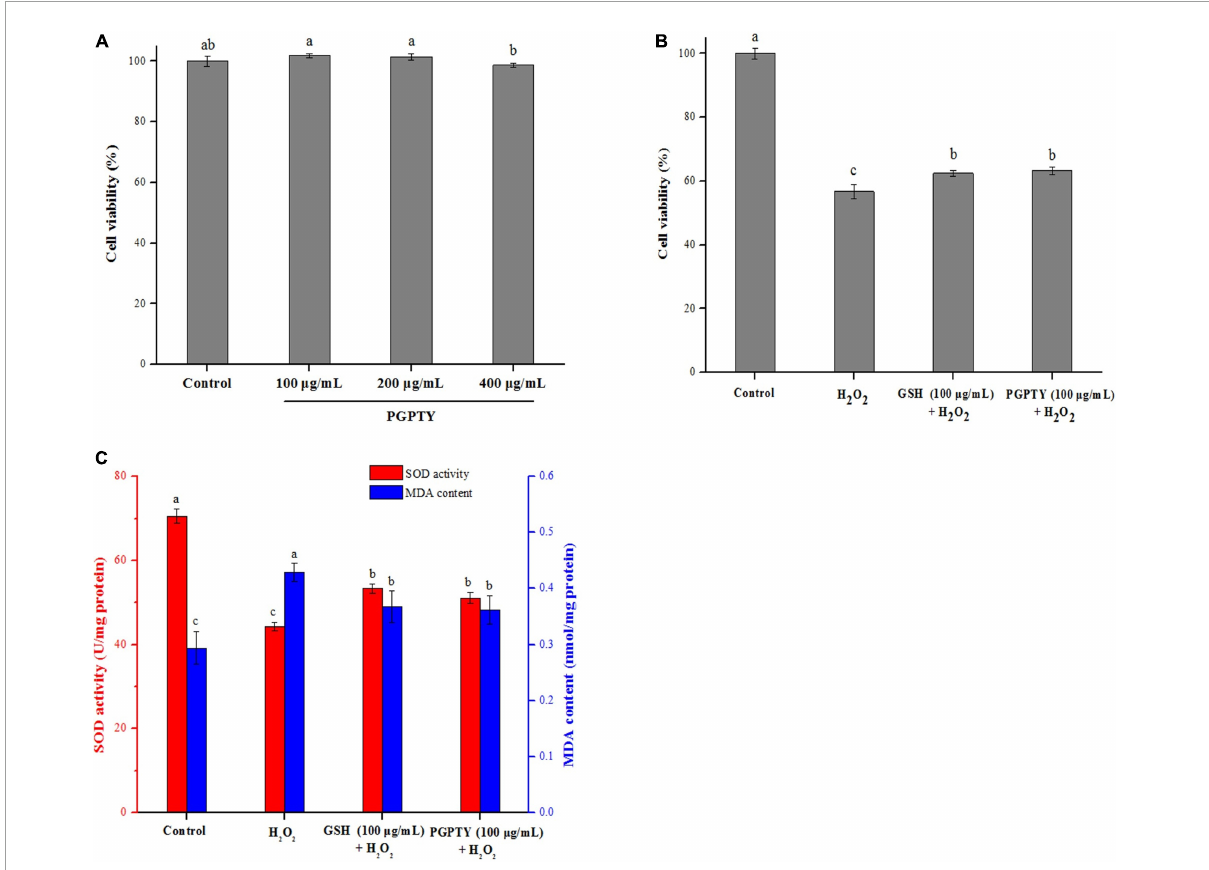
FIGURE6 Protective impacts of antioxidant peptide against H 2 O 2 -induced stress damage in HepG2 cells. (A) Cytotoxicity of PGPTY at varying concentrations in HepG2 cells. (B) Cell viability of HepG2 cells treated with H 2 O 2 , GSH + H 2 O 2 and PGPTY + H 2 O 2 . (C) SOD activity and MDA con-tent of HepG2 cells treated with H 2 O 2 , GSH + H 2 O 2 and PGPTY + H 2 O 2 . Different lowercases above the error bar suggest obvious differences of groups ( p < 0.05).